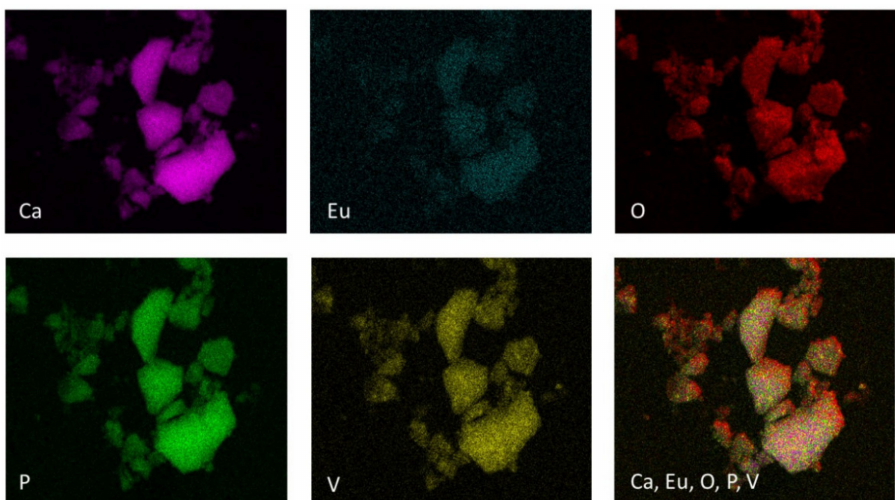
Figure 4. SEM-EDS mapping of Ca 9.8 Eu 0.2 (PO 4 ) 4 (VO 4 ) 2 (OH) 2 compound showing the elemental composition: calcium, phosphorous, europium, vanadium, and